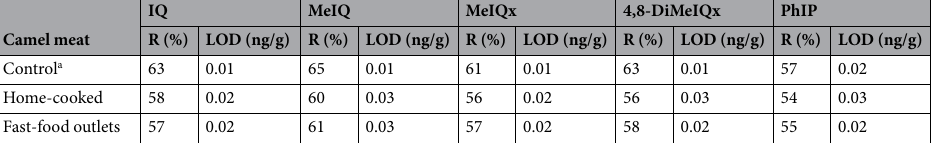
Table 1. Recovery rates (R) and limit of detection (LOD) of HCAs in cooked camel meat burgers. a Meat cooked without food additives.